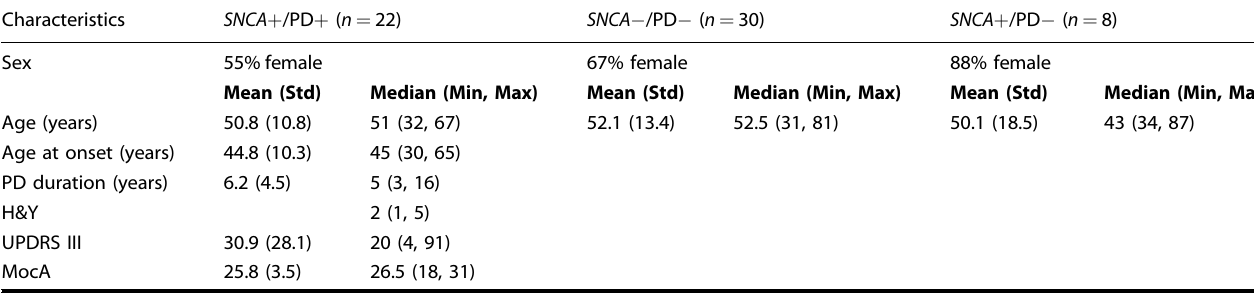
Table 3. Demographic and Parkinson ’ s disease characteristics of the